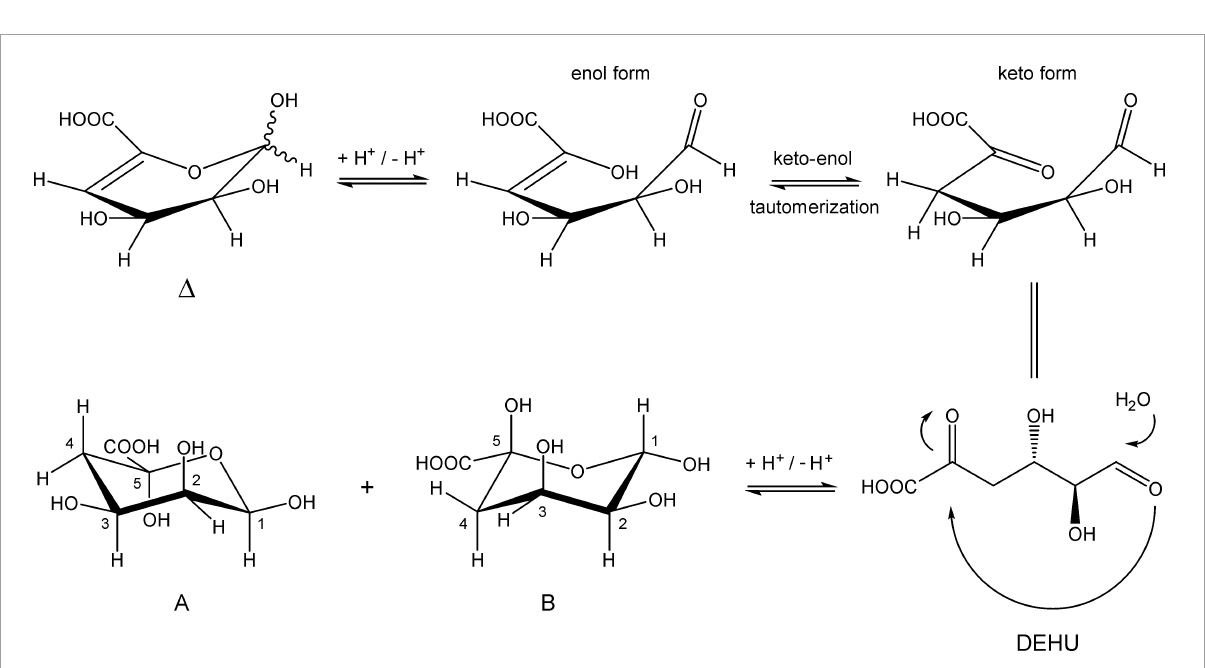
FIGURE9 Conversion of 4-deoxy- L - erythro -hex-4-enopyranosyluronic acid into two cyclic hemiacetal structures in an aqueous solution.